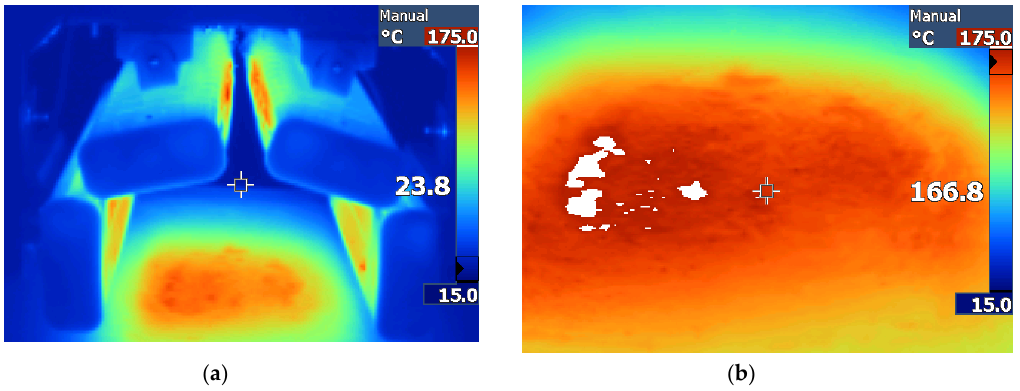
Figure 14. ( a ) Thermal image of an asphalt roll being heated by four heaters. ( b ) Temperature distribution on the asphalt top surface.